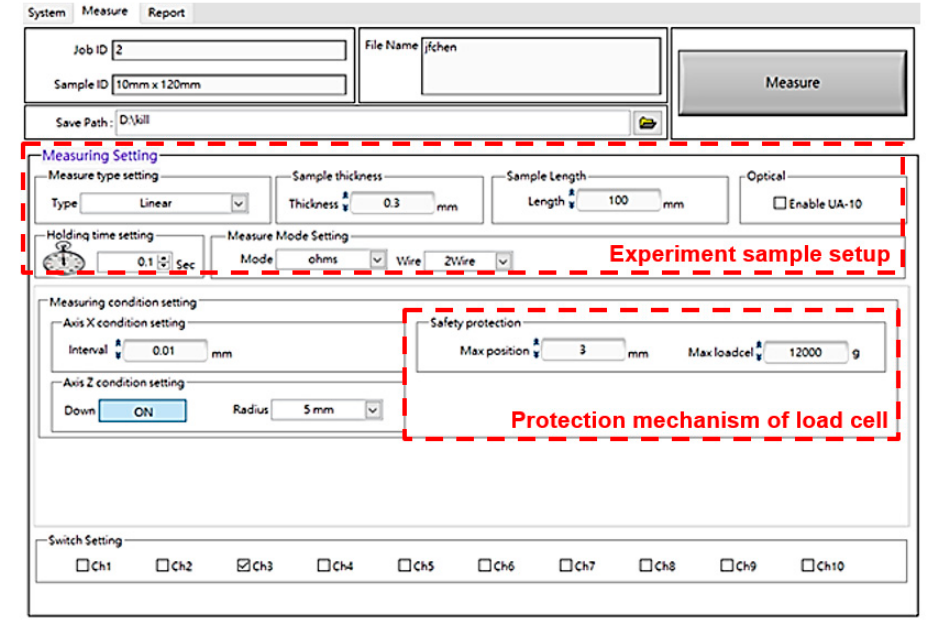
Figure 8. Setting and data output of the measurement system interface.